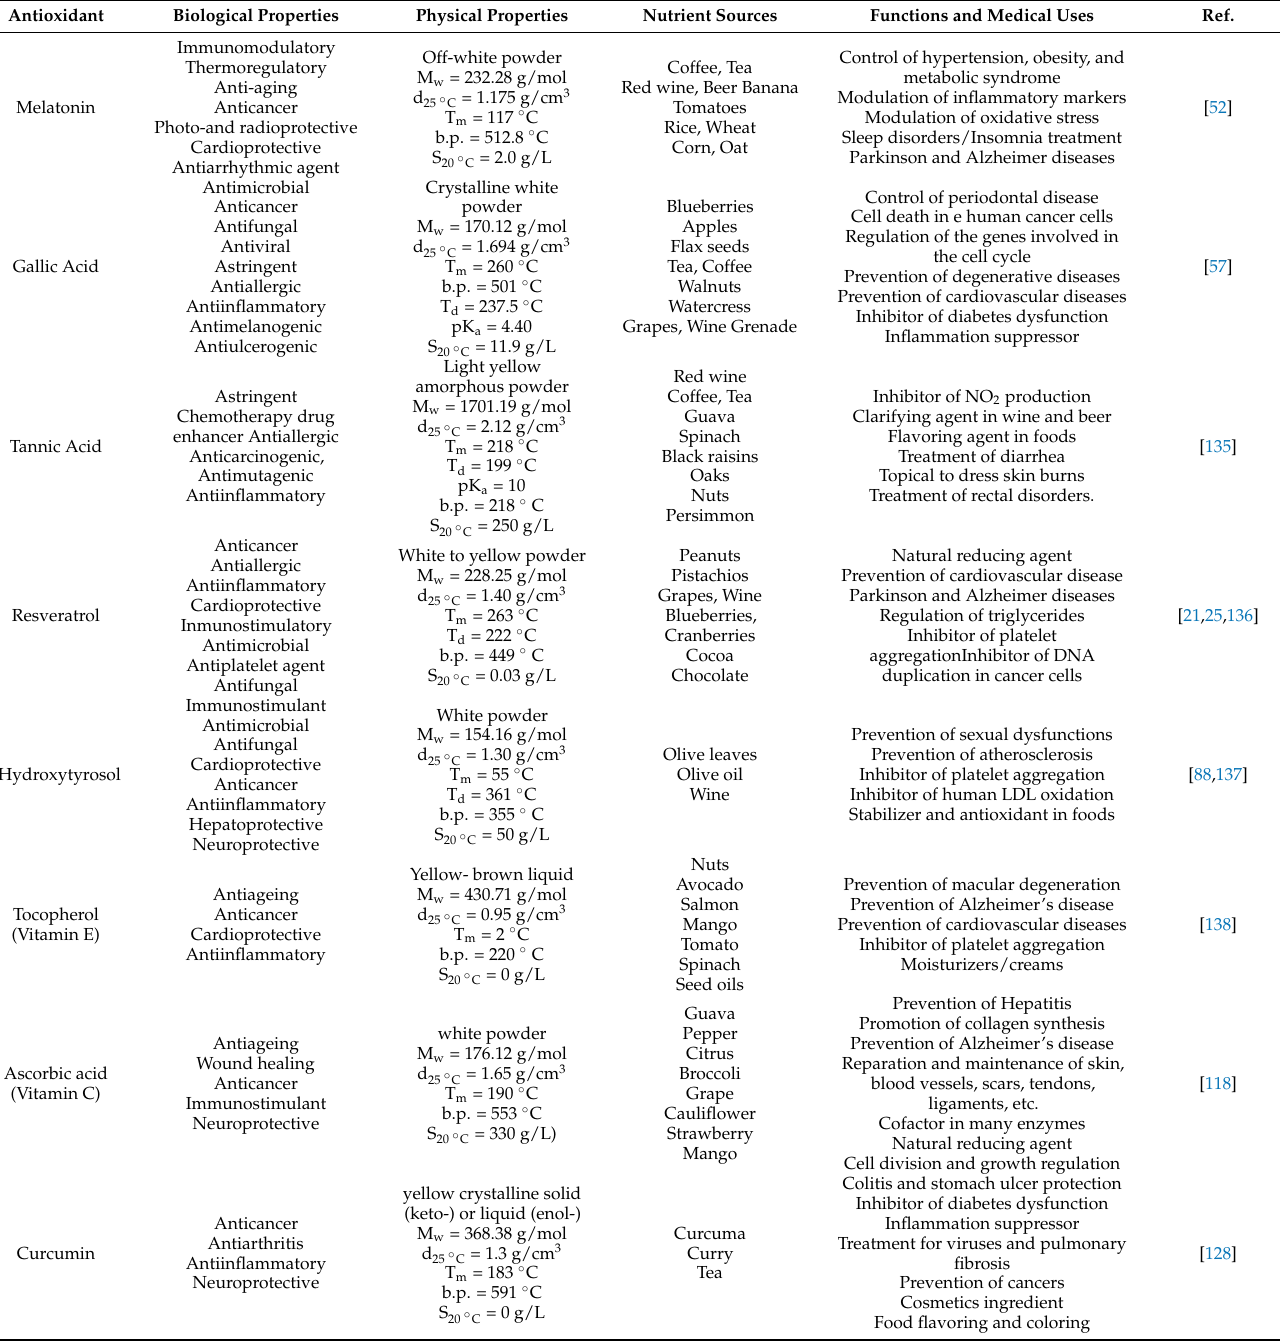
Table 1. Biological and physical properties of the antioxidants, their nutrient sources, and medical uses.